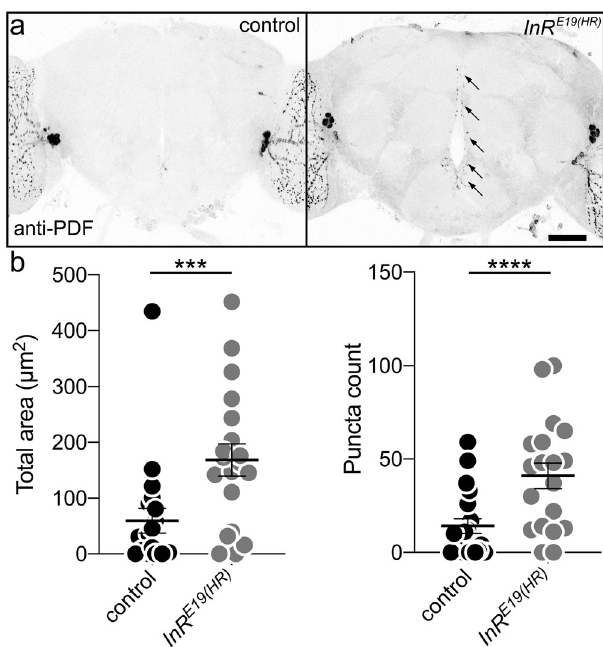
Fig. 8 Insulin receptor signaling drives developmental clearance of PDF- Tri neurons. a Whole brains (5 DPE) labeled with anti-PDF in the control ( w ; InR wildtype(HR) , right) and the insulin receptor (InR) mutant ( w ; InR E19(HR) , left). The PDF + adult-persistent ventral lateral neurons (LN v s) within the lateral brain optic lobes serve as valuable internal controls for both brain labeling and orientation. The developmentally transient PDF-Tri neurons along the central brain midline are absent in the matched genetic background controls, but persist when the InR signaling function is eliminated (arrows). Scale bar: 50 μ m. b Quanti fi cation of anti-PDF area (left) and PDF + puncta (right) in the two genotypes. Area: two-sided t test, p = 0.0002, 39.84 ± 10.94 n = 19 control, 168.4 ± 28.86 n = 19 InR E19(HR) . Puncta: two-sided Mann – Whitney, p < 0.0001, 6.563 ± 1.891 n = 16 control, 41.00 ± 6.841 n = 19 InR E19(HR) . Scatter plot graphs show mean ± SEM. Sample size is n = number of animals. Signi fi cance: p < 0.001 (***) and p < 0.0001 (****). Source data for this fi gure are provided in Source Data fi